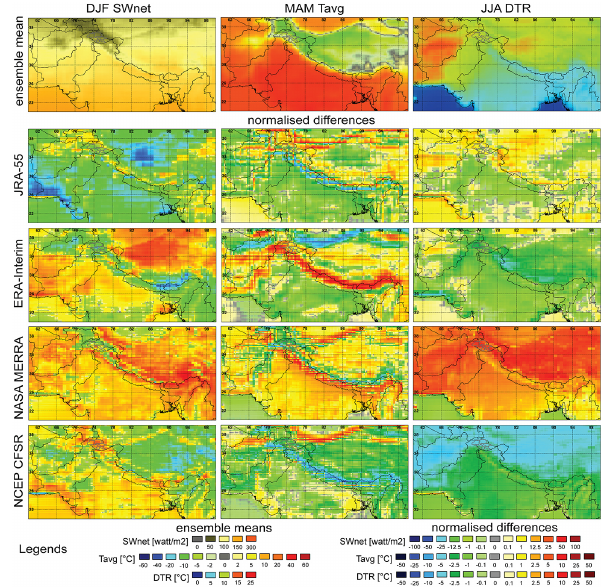
Figure 3. Ensemble energy input (temperature and radiation) cli- matology and normalised comparison of individual contributions from reanalyses used in this study. SW net is net downward short- wave radiation at the surface. T avg is daily mean near surface air temperature. DTR is diurnal temperature range. DJF is the (winter) period December through to February. MAM is the (spring) period March through to May. JJA is the (summer) period June through to